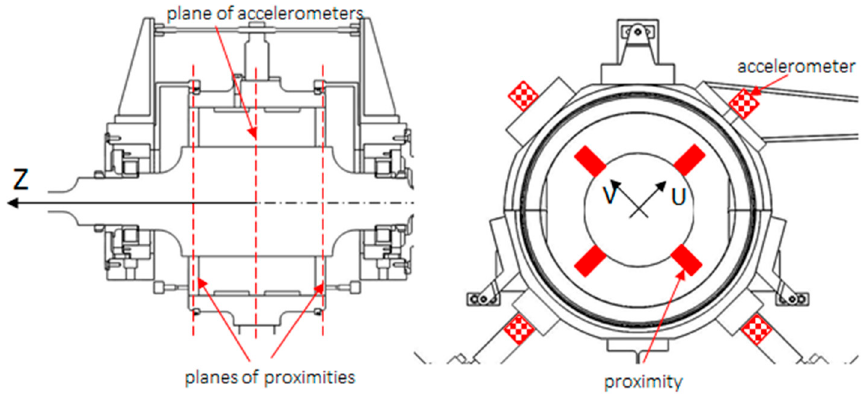
Figure 2. Drawing of the test cell.